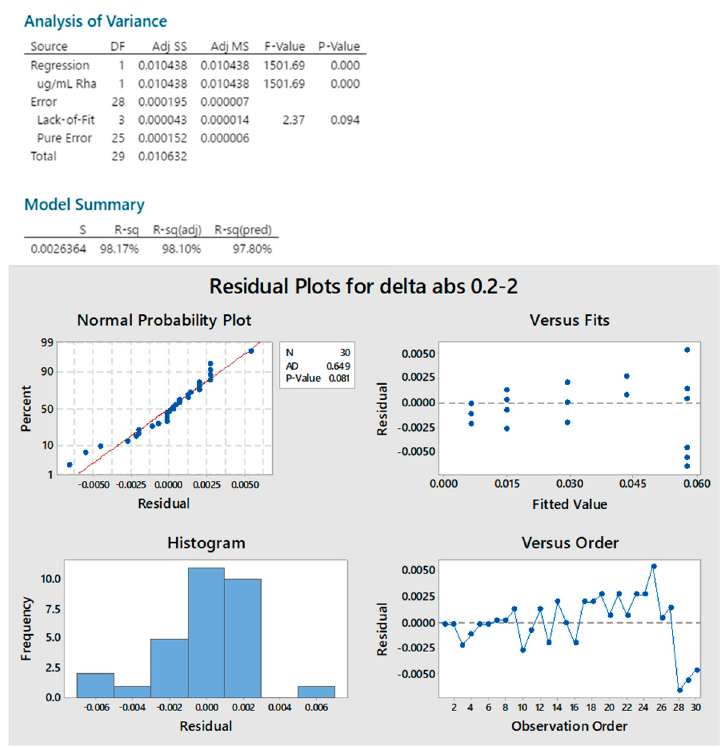
Figure A3. Standard Linearity determination for Dische colorimetric method: ANOVA on 5 replicates of the calibration curve.